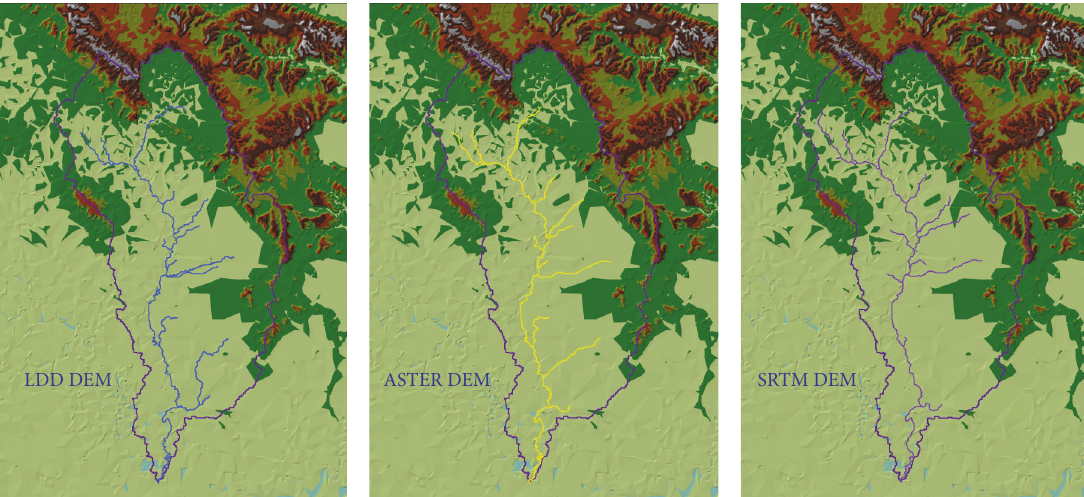
Figure 9: Stream lengths extracted from DEMs of Nam-Yang